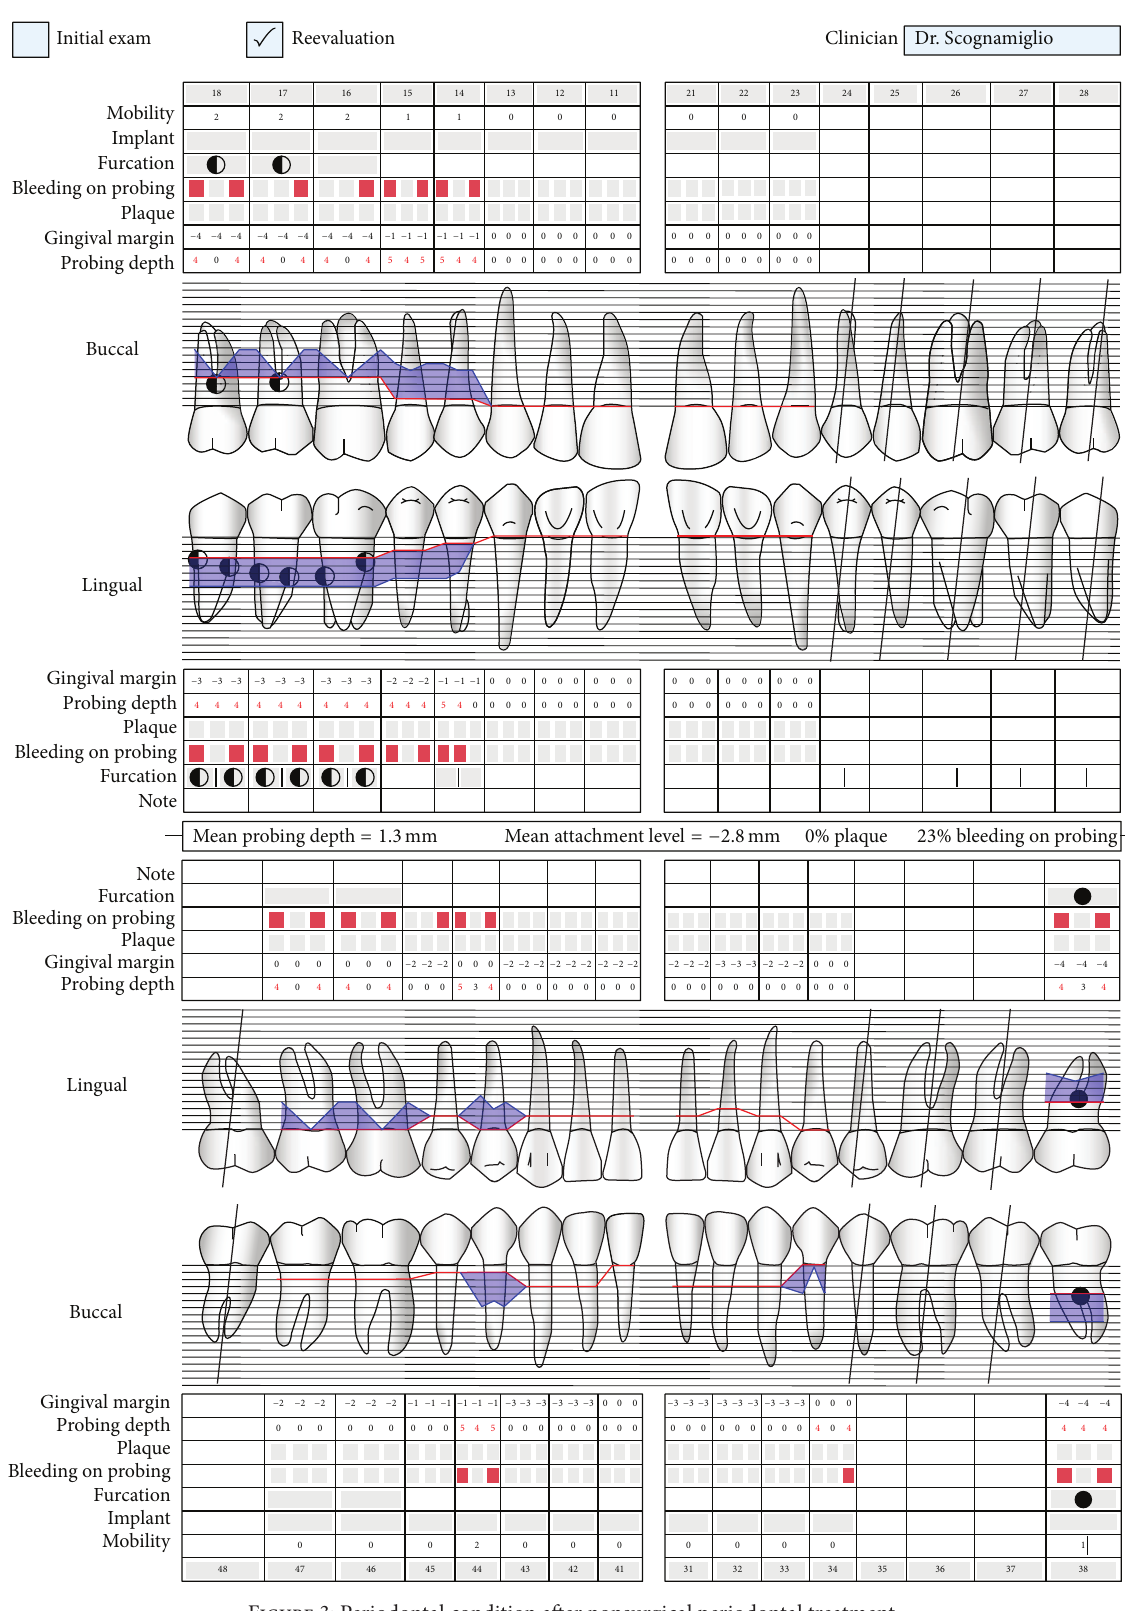
Figure 3: Periodontal condition after nonsurgical periodontal